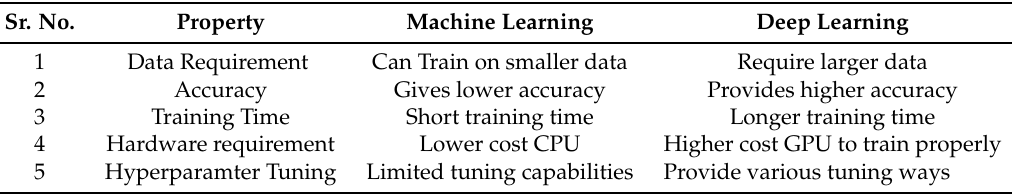
Table 1. Comparison between the classical machine learning and deep learning benefits on their key properties.